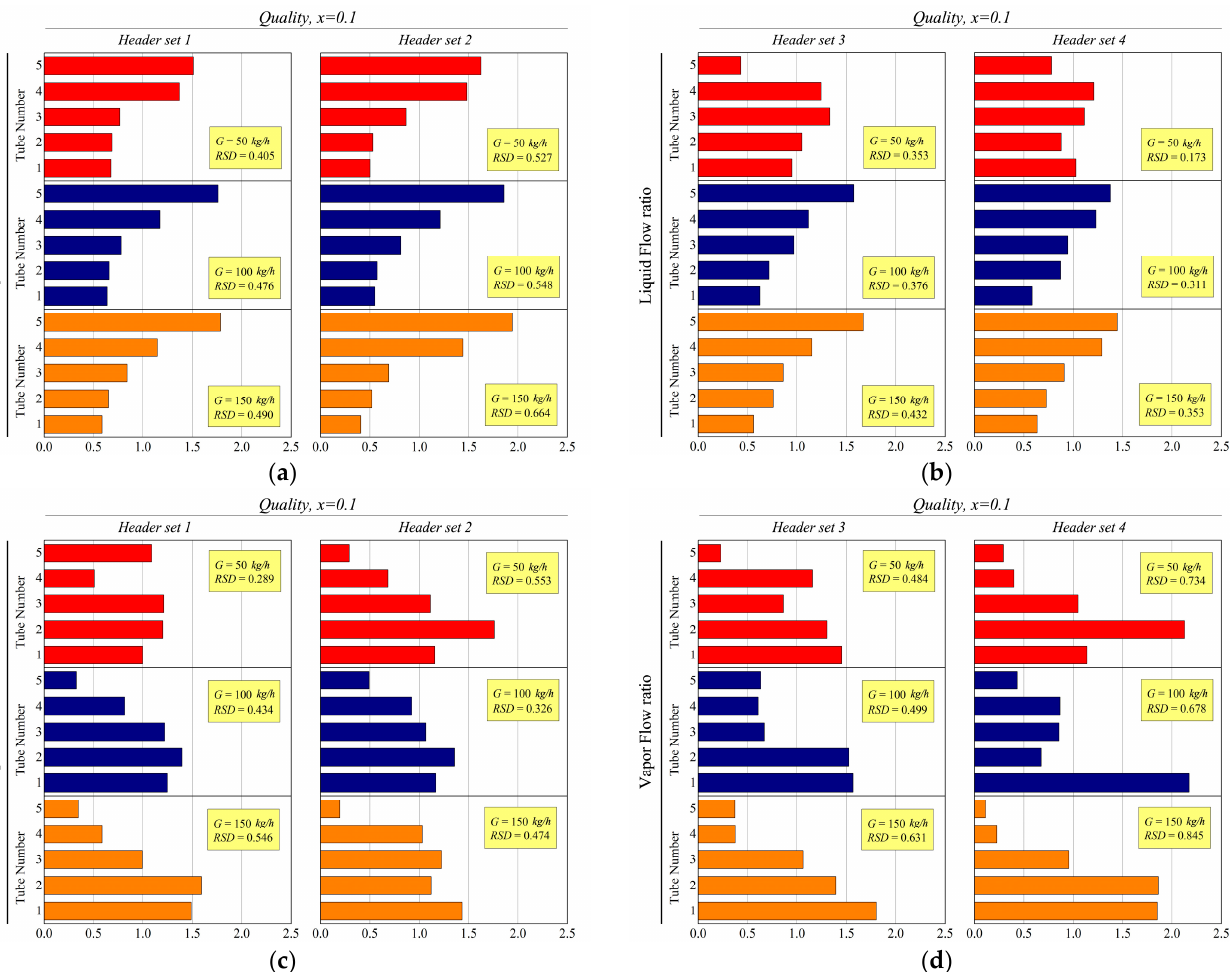
Figure 8. Effect of header outlet tube diameter to flow distribution profile: ( a ) liquid flow ratio, header sets 1 and 2 (190 mm); ( b ) liquid flow ratio, header sets 3 and 4 (490 mm); ( c ) vapor flow ratio, header sets 1 and 2 (190 mm); ( d ) vapor flow ratio, header sets 3 and 4 (490 mm).